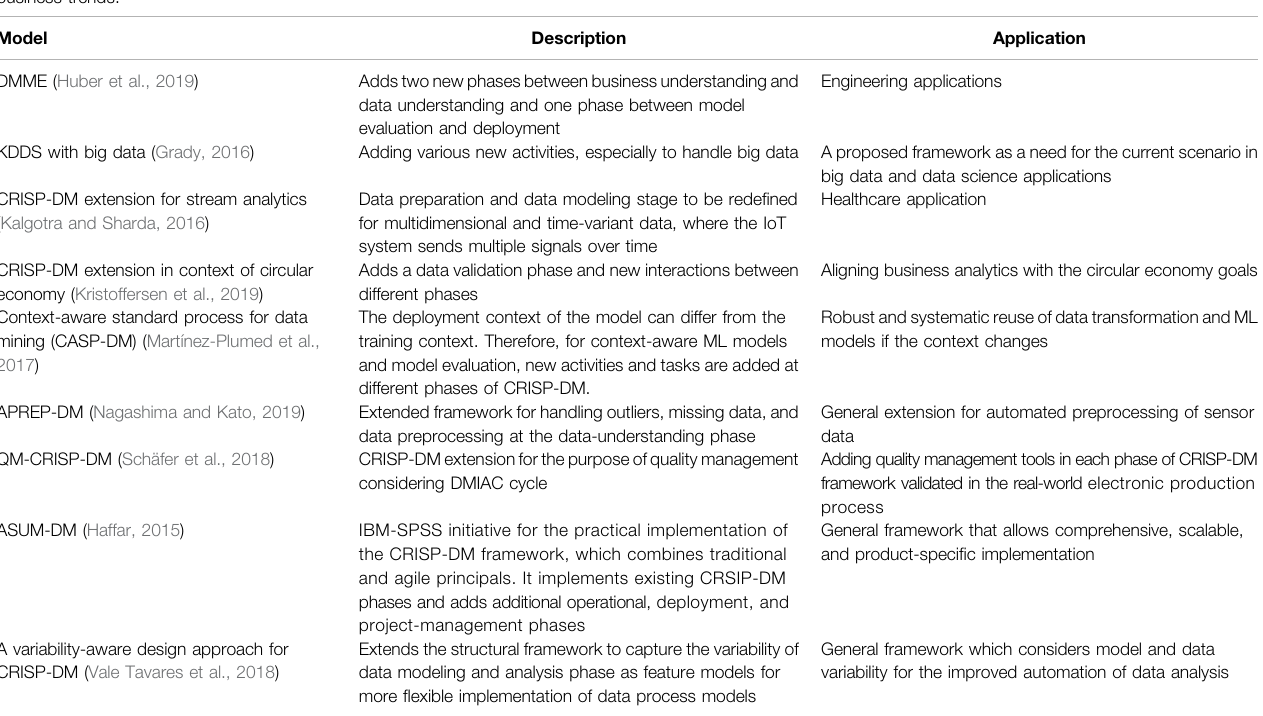
TABLE 2 | List of extensions of the CRISP-DM process model framework based on industry-speci fi c requirements (application-speci fi c requirements) due to changing business trends. Model Description